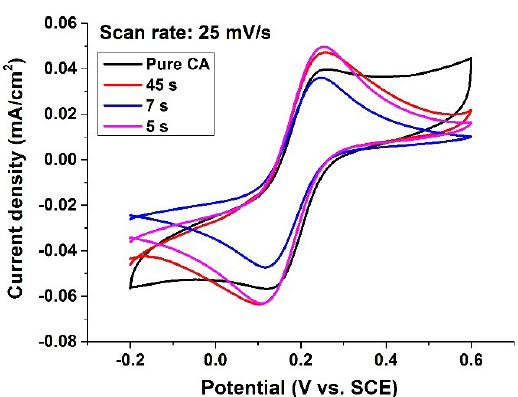
Figure 5. Comparison of the synthesized electrodes and pure carbon aerogel voltammograms at a scan rate of 25